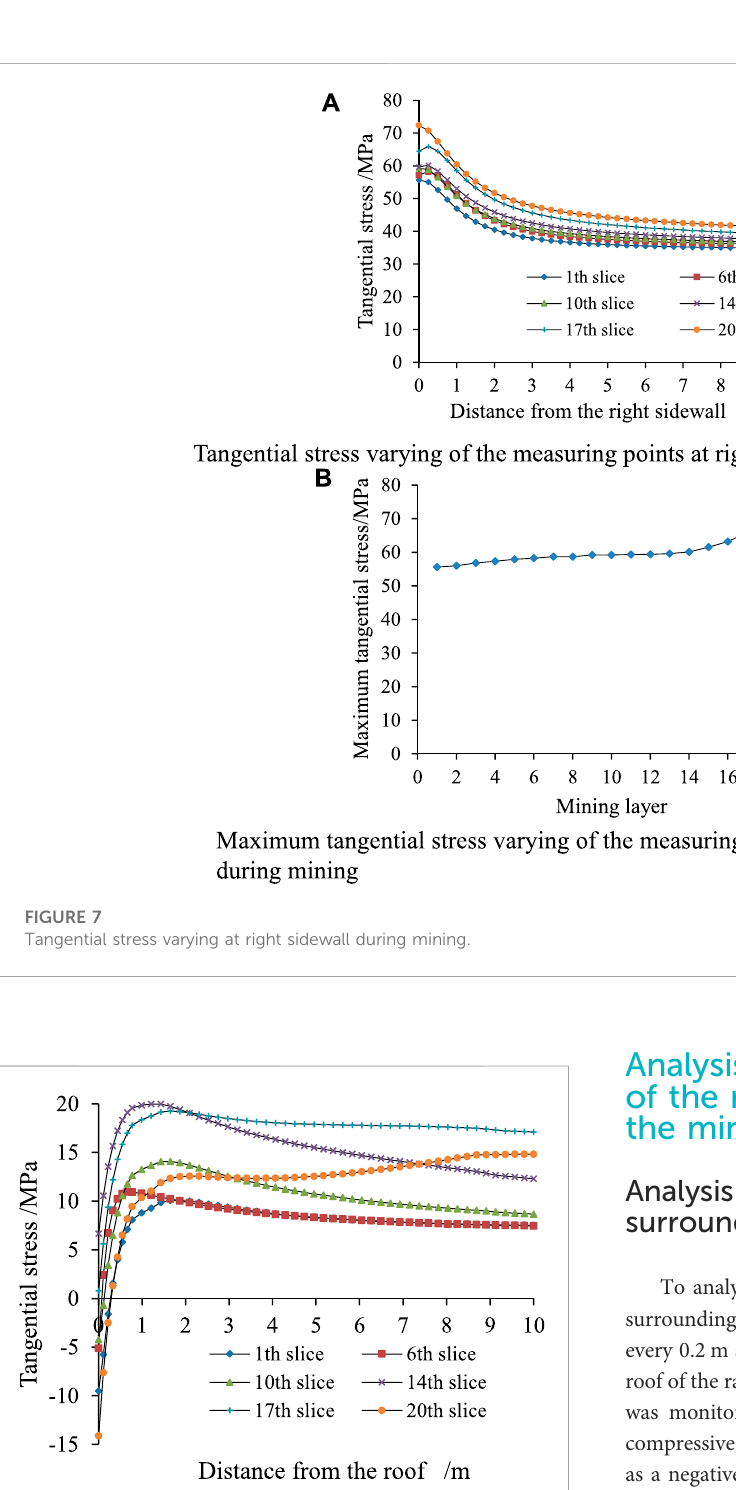
FIGURE 8 Tangential stress varying of roof during